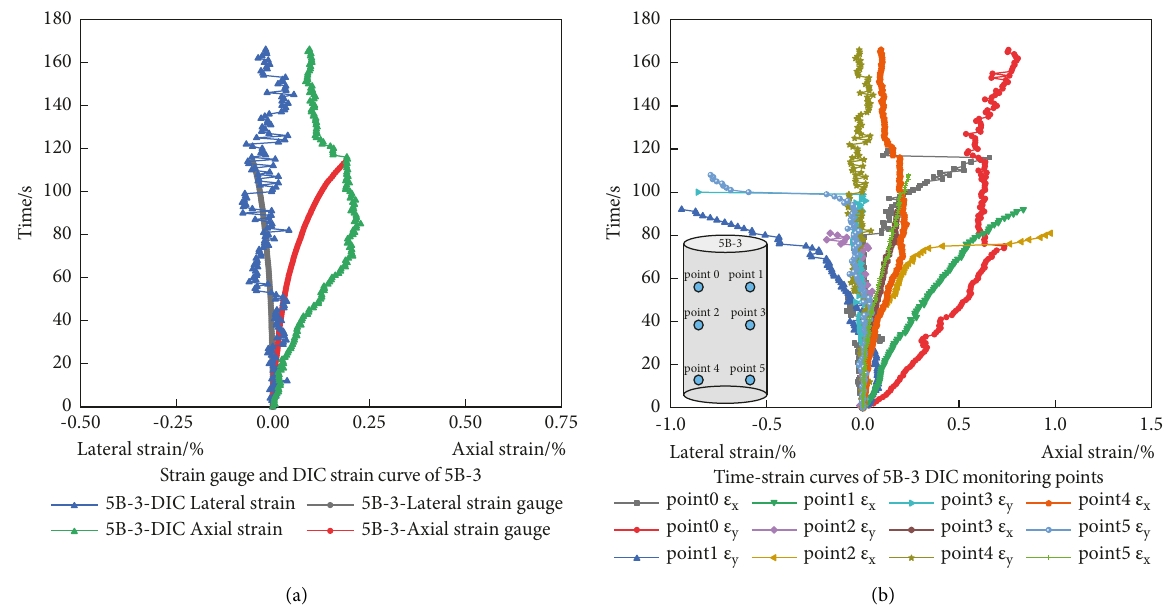
Figure 13: Time-strain curve of 5B-3. (a) Strain gauge and DIC strain curve of 5B-3. (b) Time-strain curves of 5B-3 DIC monitoring points.